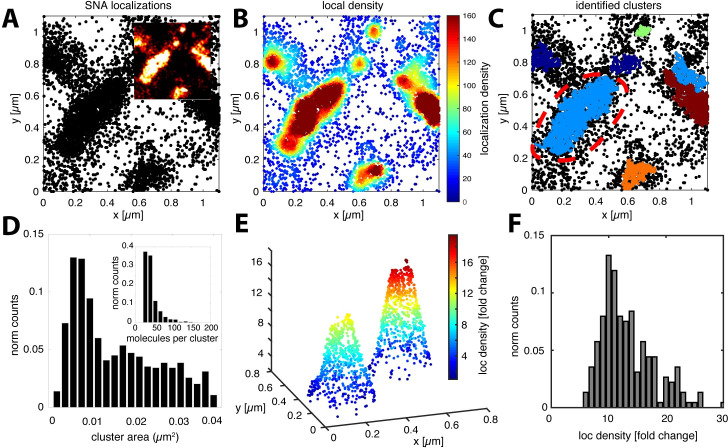
Density-based localization analysis reveals small SA clusters between microvilli.(A) Spatial distribution of STORM localizations from SNA-A647 on A549 cells showing the coexistence of two structural features, (1) large microvilli as well as (2) small nanodomains. The inset in A shows a pixel image reconstruction (10 nm/pxl) of the localization map in A. (B) Density distribution of localizations shown in A within a search radius of 50 nm. Color scale according to number of neighbor localizations. (C) Final clustering result with identified clusters allows quantification of the cluster area. After all identified clusters were filtered according to their size to selectively analyze non-microvilli structures, we found clusters with an area between 0.005–0.04 μm2 (D). The large cluster labelled by the red dashed line was filtered out (see also S4 Fig). Distribution of the number of molecules per cluster as estimated according to the number of localizations (D, inset). The inner structure of non-microvilli clusters was analyzed according to their local localization density (B). (E) Representative example of two identified clusters showing their inner density gradient. The color code represents the number of nearest neighbor localizations within a radius of 30 nm (i.e. the local localization density). The localization density is plotted on the vertical axis. Distribution of the density difference between background and the cluster center over all identified cluster (F).